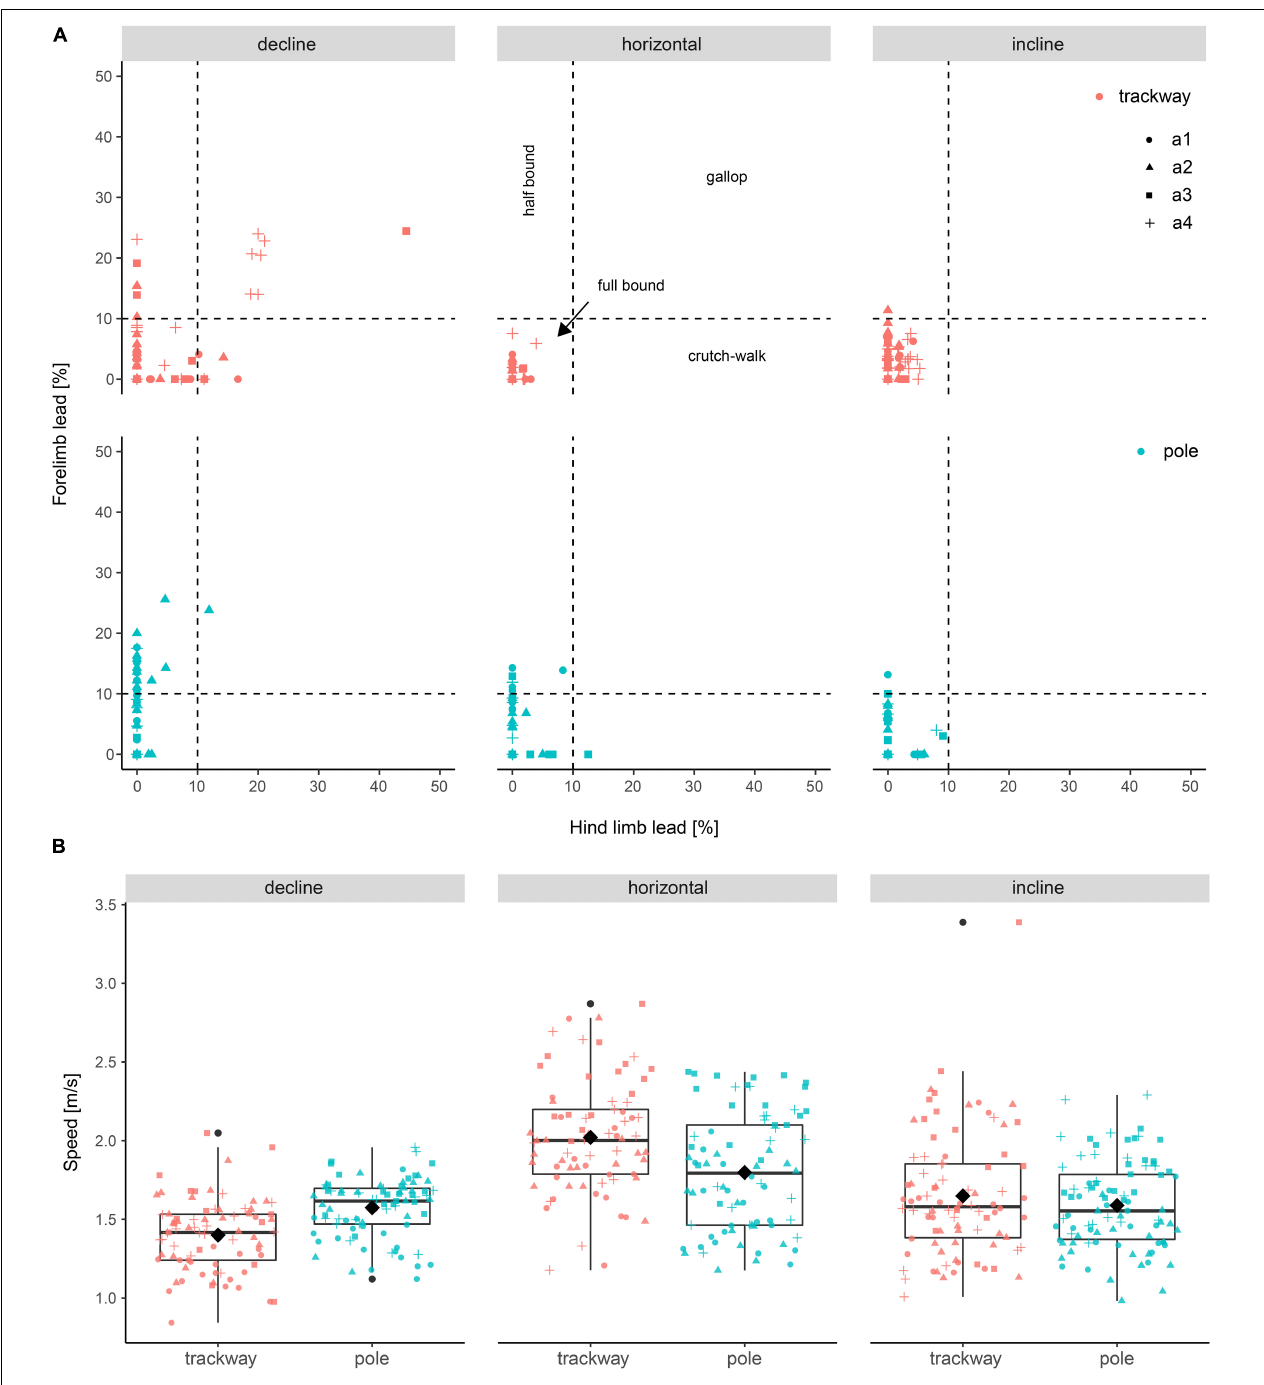
FIGURE 2 | Forelimb lead versus hind limb lead and speed differences among setups. (A) Lead used to quantify asymmetrical gaits. Cut-off values according to Hildebrandt (1977). Trials with a forelimb and hind limb lead < 10% are categorized as full bounds, trials with forelimb lead > 10% and hind limb lead < 10% are categorized as half bounds, trials with forelimb lead < 10% and hind limb lead > 10% are categorized as crutch walks, and trials with forelimb and hind limb lead > 10% are categorized as gallops. (B) Speed distributions shown as boxplots. a1–a4 refer to the studied individuals.